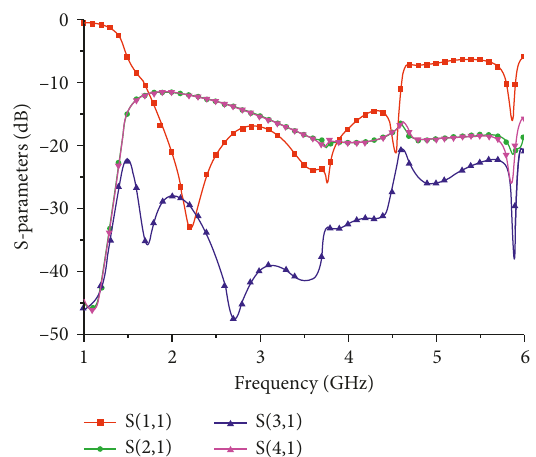
Figure 8: The simulated isolation performance of the MIMO antenna without slot.